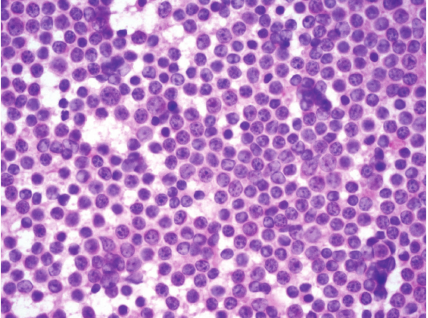
Figure 2: Touch imprint of the eyelid masses showing a monotonous population of small, mature lymphocytes (Wright- Giemsa; 500x magnification).